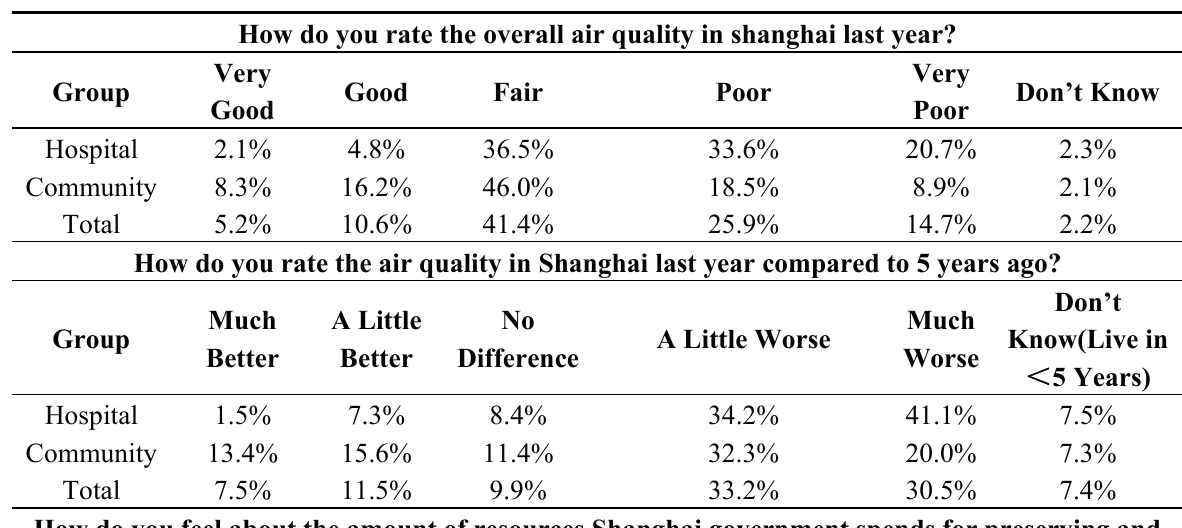
Table 4. Residents’ attitudes to the government